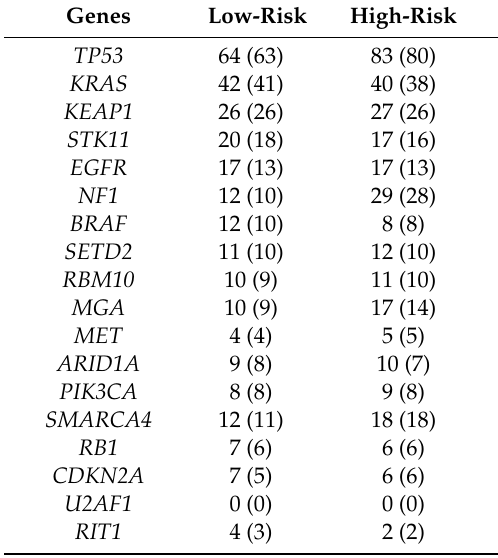
Table 5. Gene mutations analysis of 18 genes reported as having a statistically significant mutation in the LUAD dataset. Gene names and number of mutations (number of patients) are summarized.